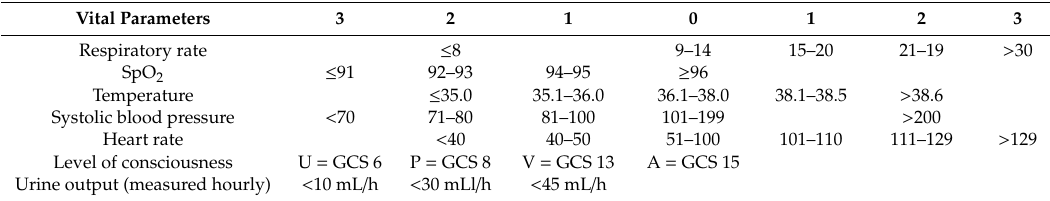
Table 2. Modified Early Warning Score